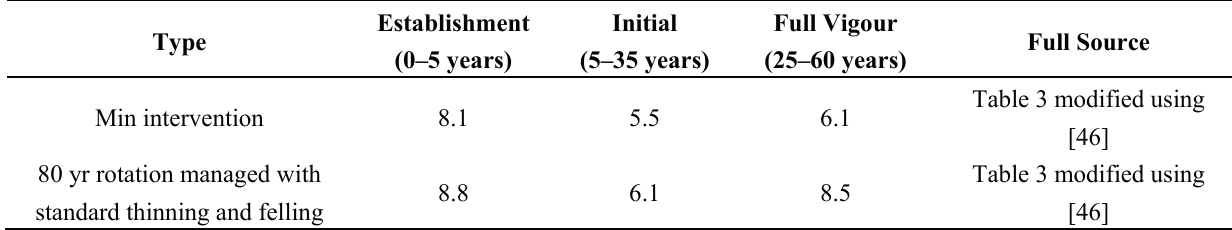
(i) minimum intervention; and (ii) 80 year rotation with standard thinning and felling